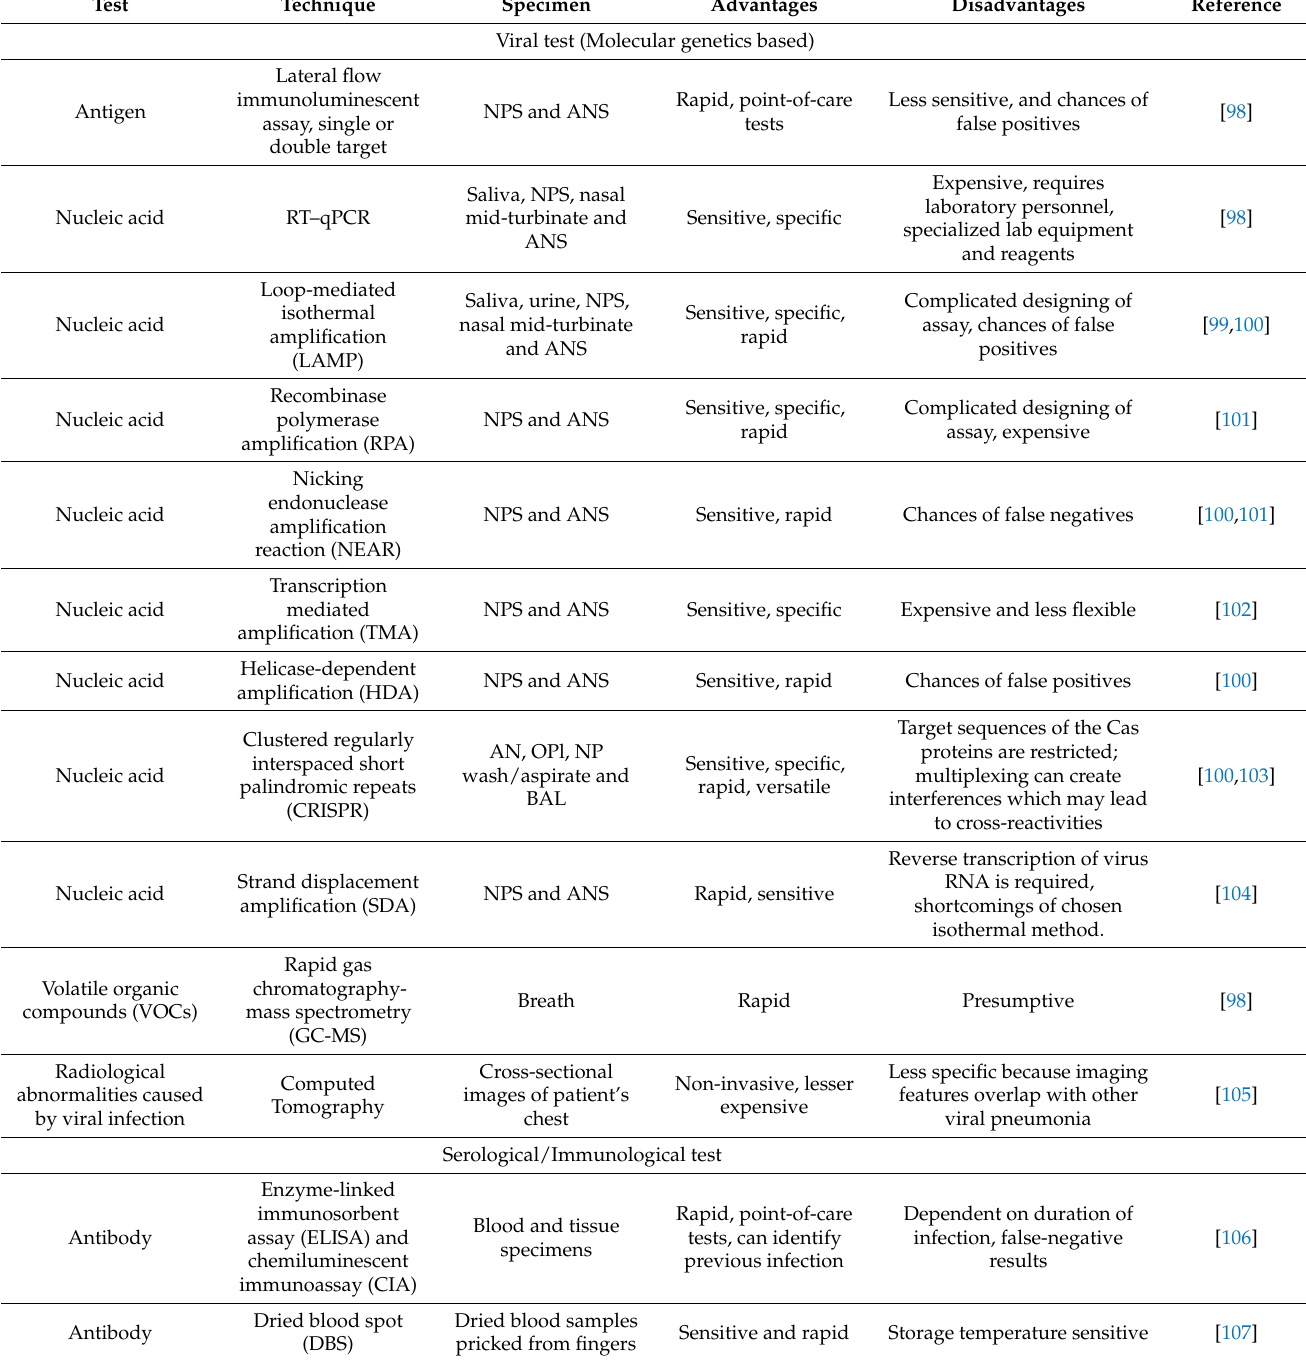
Table 2. List of different diagnostic methods in